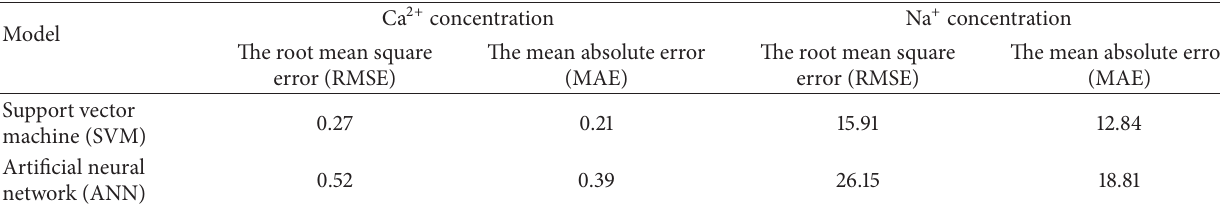
Table 3: Statistical parameters indicative of model